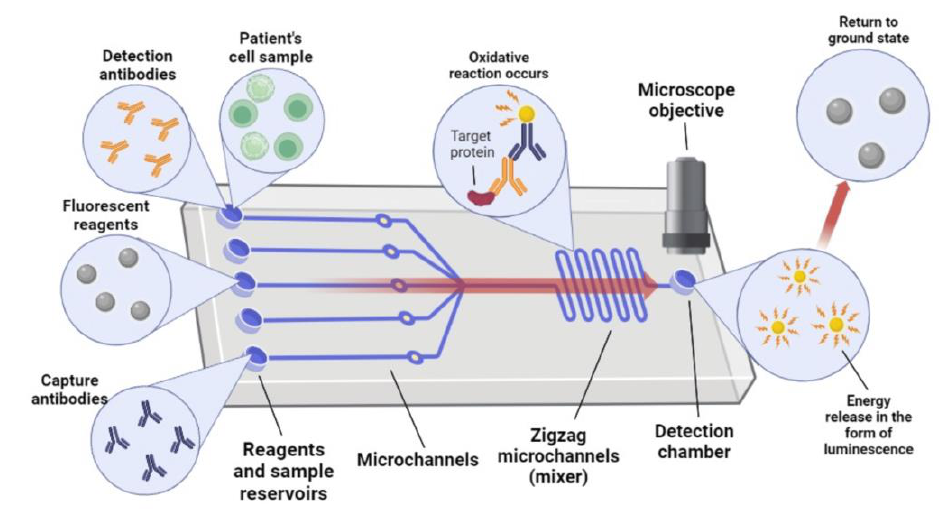
Figure 3. Schematic illustration of the microfluidic chemiluminescence biosensor. Created with Biorender.com.